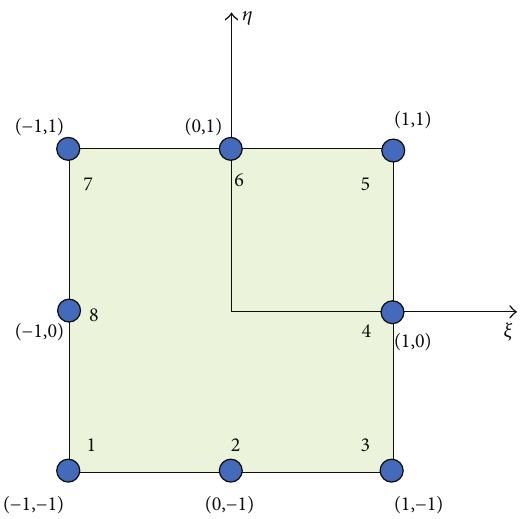
Figure6:Typicallinearinterpolationfortheframefieldsof3Dbrick